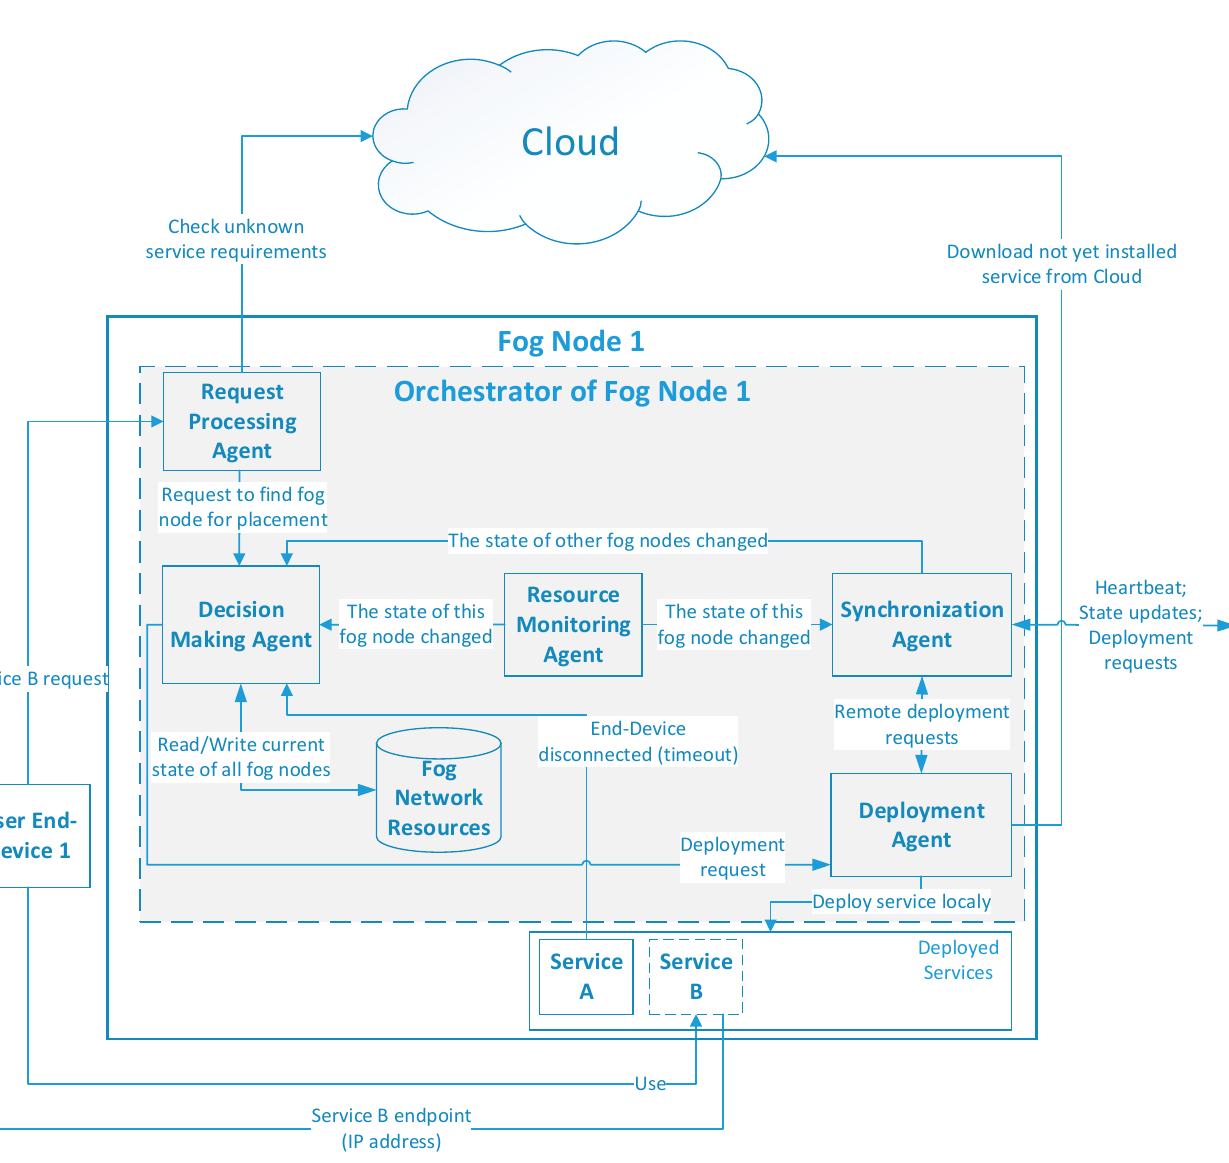
Figure 3 . Structure of the agent-based orchestrator component of one fog node. Figure 3. Structure of the agent-based orchestrator component of one fog